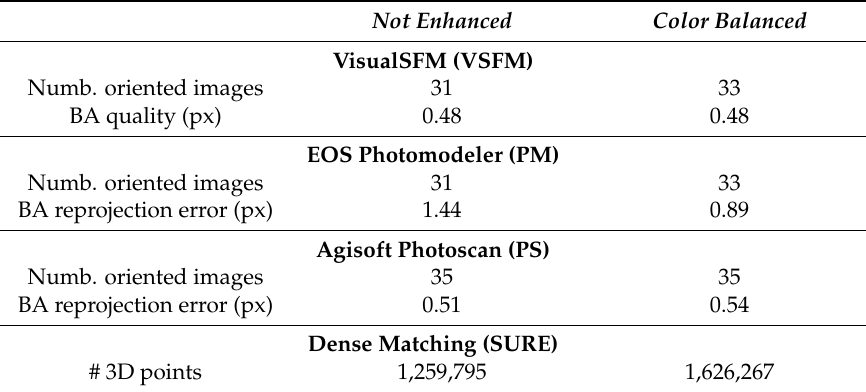
Table 2. Bundle adjustment (BA) results and dense matching improvement on Dataset 2. Not Enhanced Color